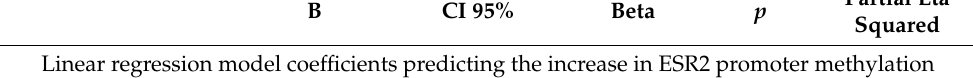
Partial Eta Squared